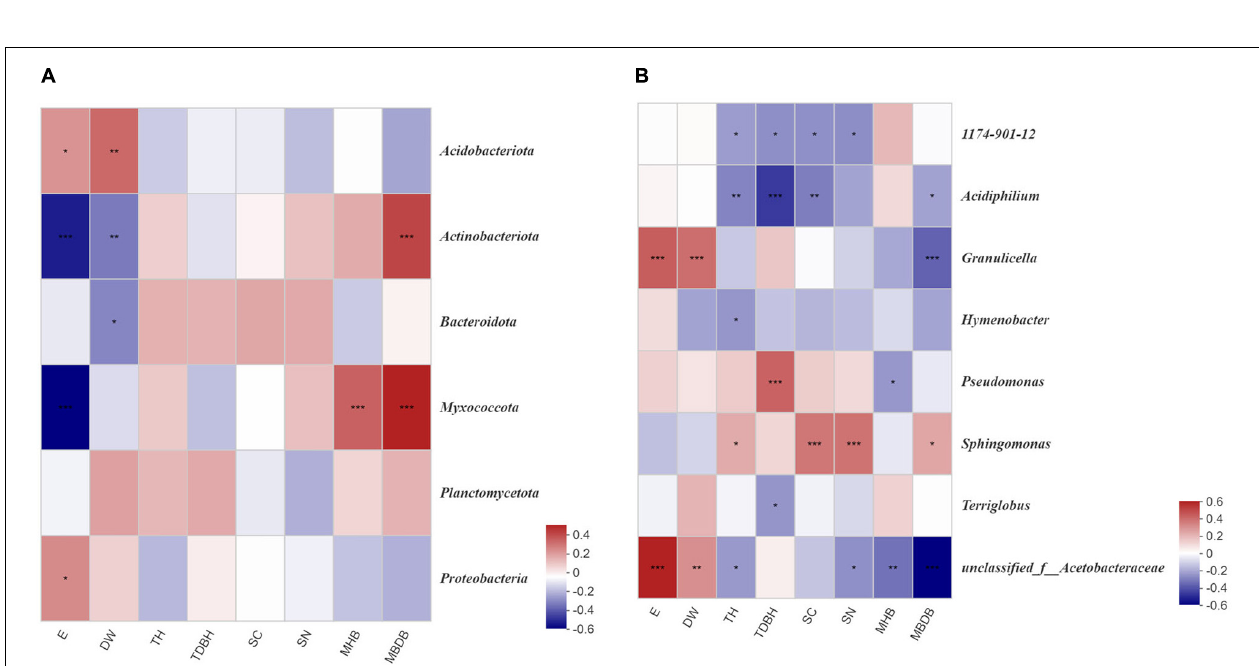
FIGURE 6 | Correlation heatmap of bamboo environmental factors and read numbers at the phylum (A) and genus (B) level for bacteria. E, elevation; DW, distance from water; TH, trees height; TDBH, trees diameter at breast height; SC, shrubs coverage; SN, shrubs numbers; MHB, mean height of bamboo; MBDB, mean base diameter of bamboo. The color intensity in each panel indicates the relative correlation between bamboo environmental factors and read numbers of each group. *0.01 < P < 0.05, **0.001 < P < 0.01, *** P < 0.001.